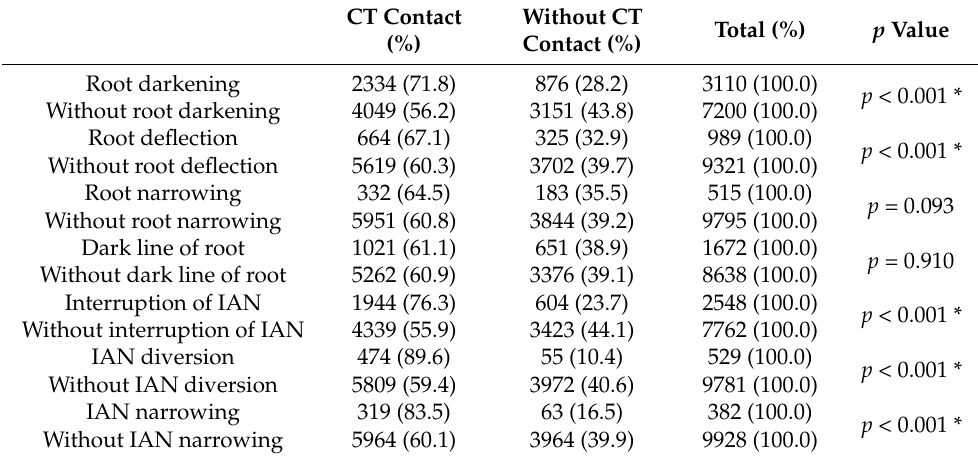
Table 7. Association between panoramic signs and contact in cone beam computed tomography (CBCT).